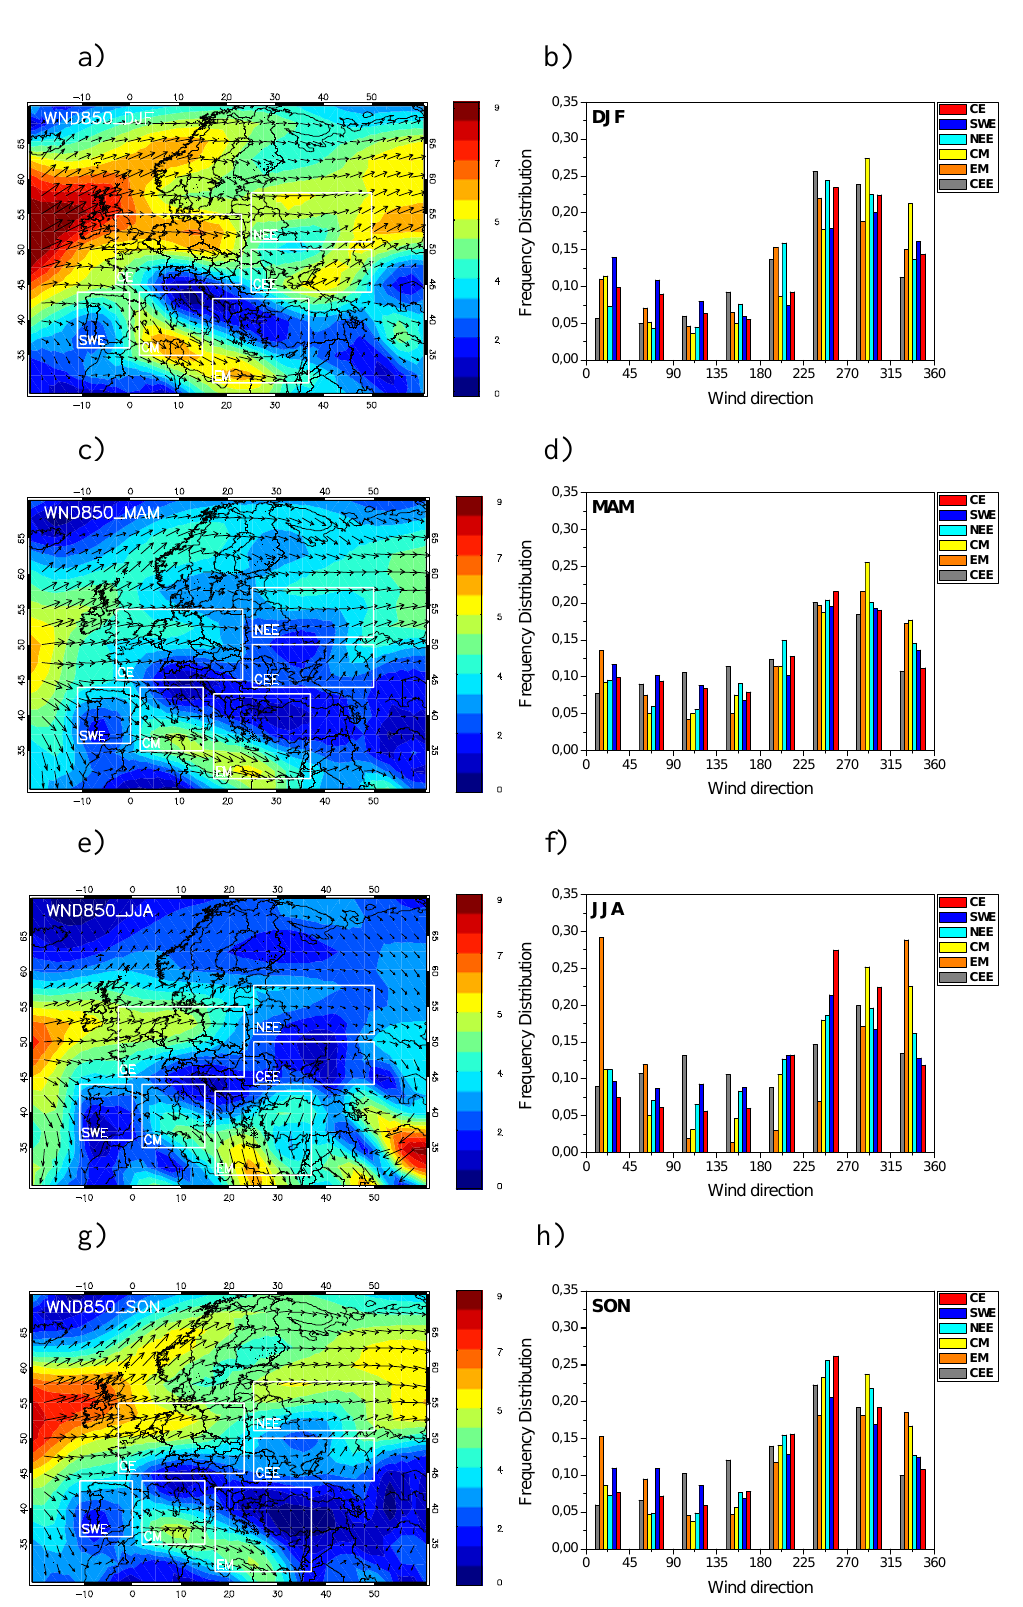
Fig. 7. (a) Average 2000–2009 NCEP/NCAR reanalysis wind speed (colorscale: 0–9ms − 1 ) and vectors at the 850mbar pressure level for DJF, (b) Frequency distribution of the wind direction over the 6 regions of interest for DJF, (c) the same as (a) but for MAM, (d) the same as (b) but for MAM, (e) the same as (a) but for JJA, (f) the same as (b) but for JJA, (g) the same as (a) but for SON, (h) the same as (b) but for